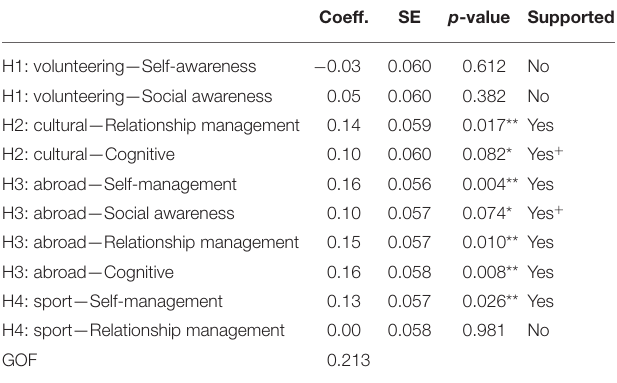
TABLE 6 | Structural